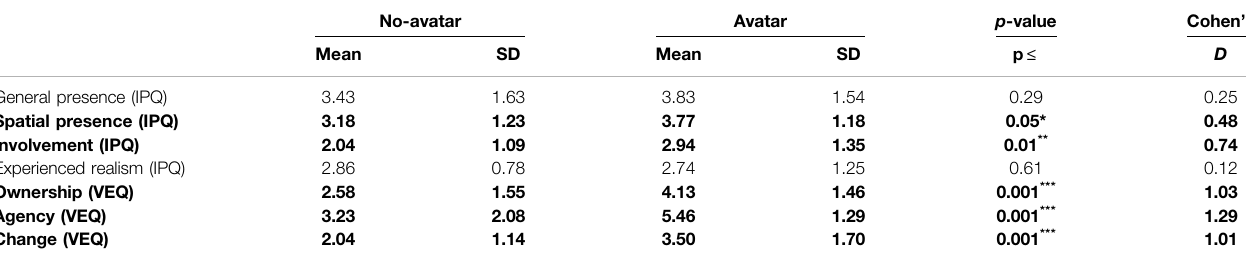
TABLE 3 | Main results — IPQ and VEQ.